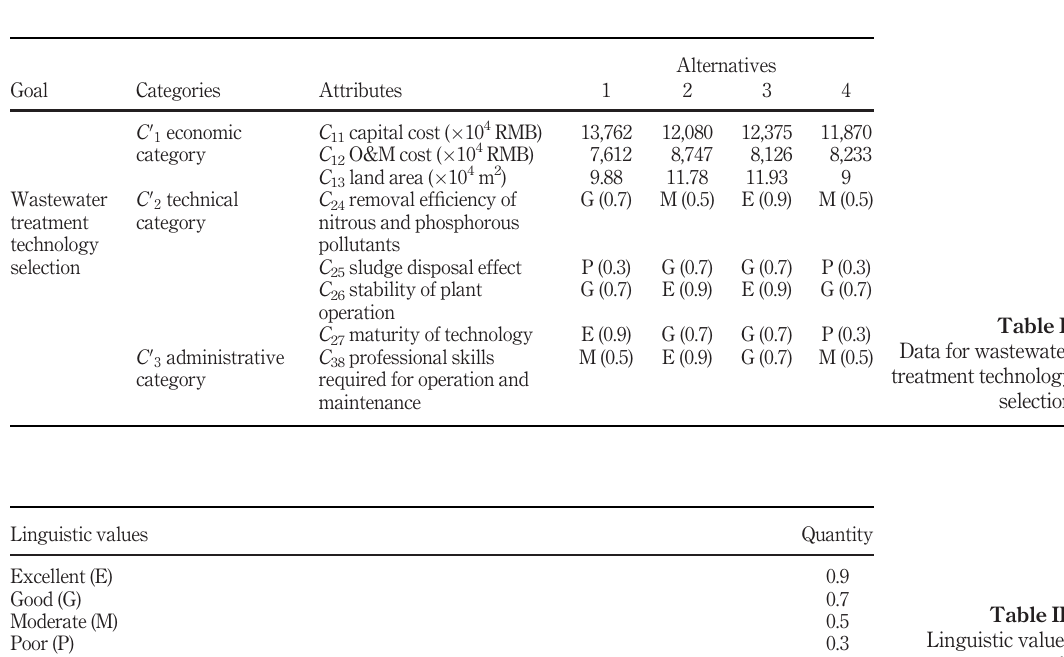
Table II. Linguistic